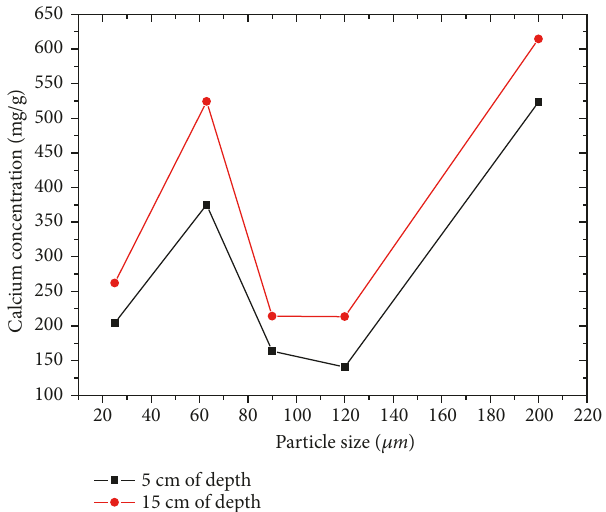
Figure 5: Evolution of calcium concentration as a function of particle size and depth.